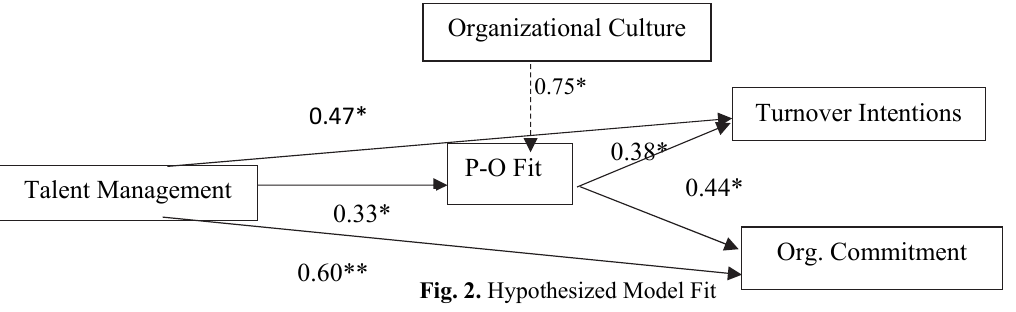
Fig. 2. Hypothesized Model